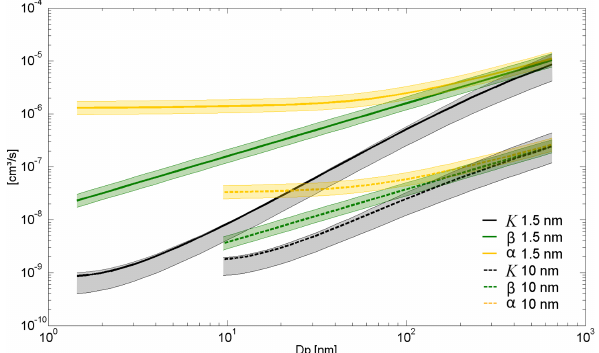
Figure 1. Coagulation coefficient K, attachment coefficient β and recombination coefficient α [cm 3 s − 1 ] for small cluster ions and particles (1.5nm, solid lines) and large ions and particles (10nm, dashed lines) as a function of ion/particle diameter D p . Shaded ar- eas denote the variability of the respective coefficients, please refer to the Appendix for